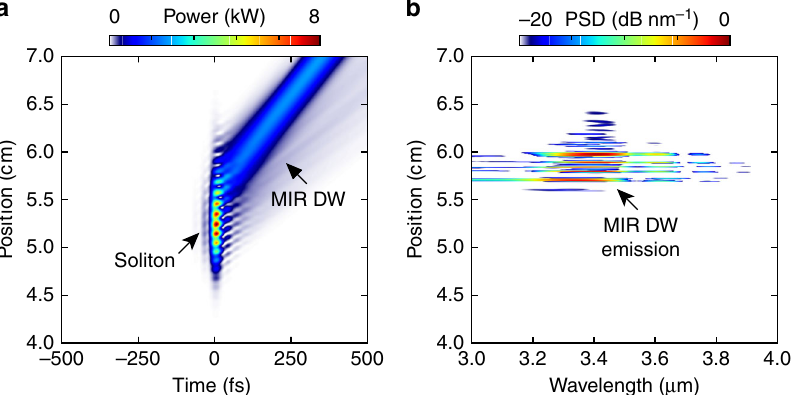
Fig. 5 Dynamics of mid-infrared dispersive wave emission. a Evolution of the temporal pulse shape with propagation distance, bandpass fi ltered between 3 and 4 μ m, for the simulation in Fig. 3. b Power spectral density (PSD, normalized to the peak of the spectrum) of a dispersive wave (DW) generated according to Eq. (2). The central wavelength of the soliton was determined from the fi rst-order centroid of its spectrum. The temporal walk-off between the soliton (central wavelength ~750 nm at the mid-infrared (MIR) DW emission point) and the MIR DW (~3.4 μ m) is 33 fs mm − 1 , yielding a gain length of ~1